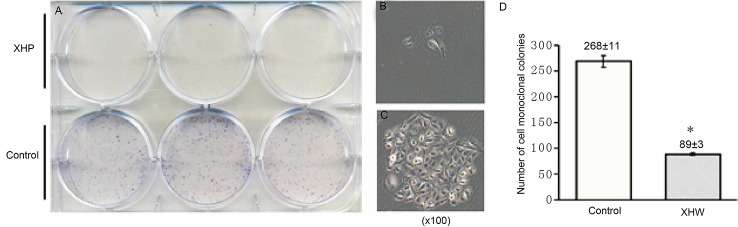
Effect of XHP on cell cloning ability. (A) is the 6-well plate culture plates after staining with crystal violet; (B, C) are the cell clones of a random set of three duplicate wells in the XHP group and the control group, respectively; (D) is the histogram of the number of cell clones in both groups; compared with the control group, *P < 0.01.